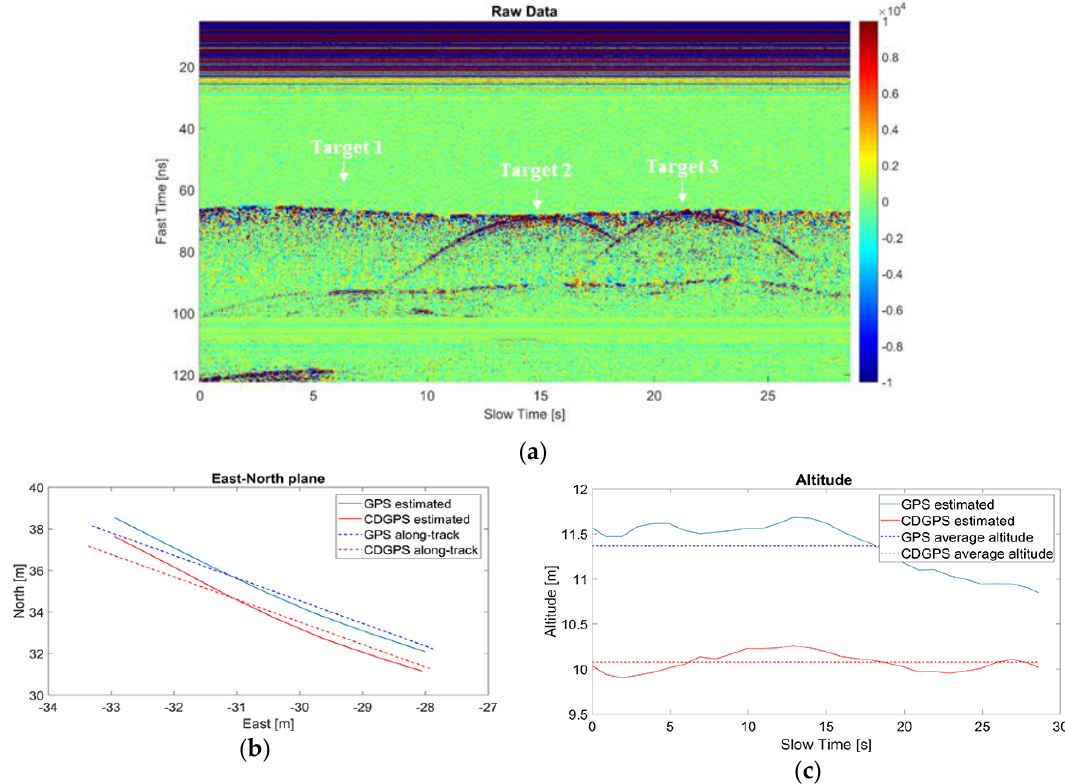
Figure 8. Test 2-Track 1: ( a ) raw data; ( b ) east–north UAV positions estimated by GPS (solid blue line) and CDGPS (solid red line), along-track direction defined by GPS (dashed blue line) and CDGPS (dashed red line); ( c ) UAV Altitude estimated by GPS (solid blue line) and CDGPS (solid red line), average altitude defined by GPS (dashed blue line) and CDGPS (dashed red line).